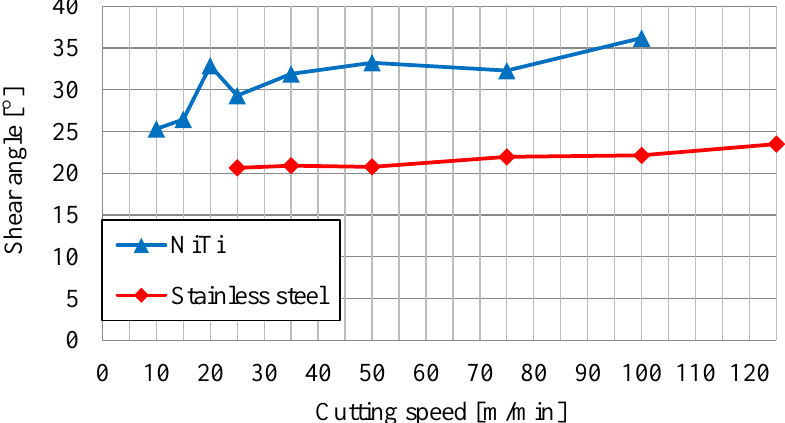
Figure 10. Cutting ratio calculated from the shear surface theory.